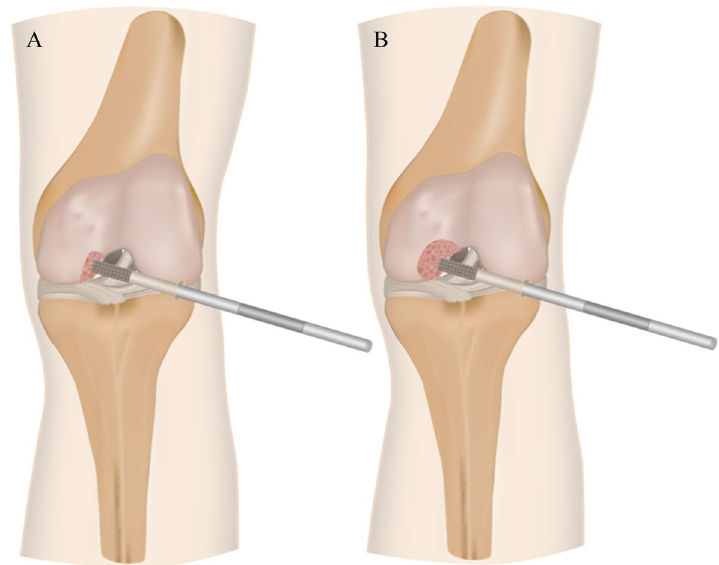
Fig. 3 Schematic illustration of the two different notchplasty states applied under arthroscopic surgery in the medial compartment: A ) Conventional tissue resection (Notch) and B ) extended tissue removal (xNotch) in the intercondylar